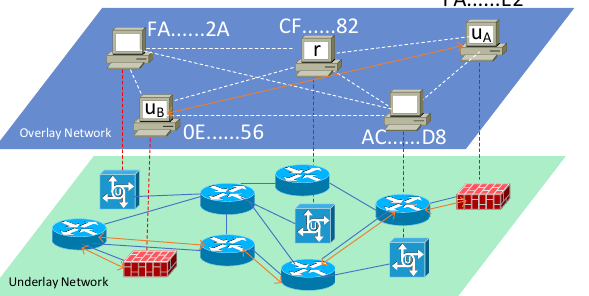
Figure 11. Direct connection packet flow diagram for unreachable nodes u A and u B in the overlay and underlay